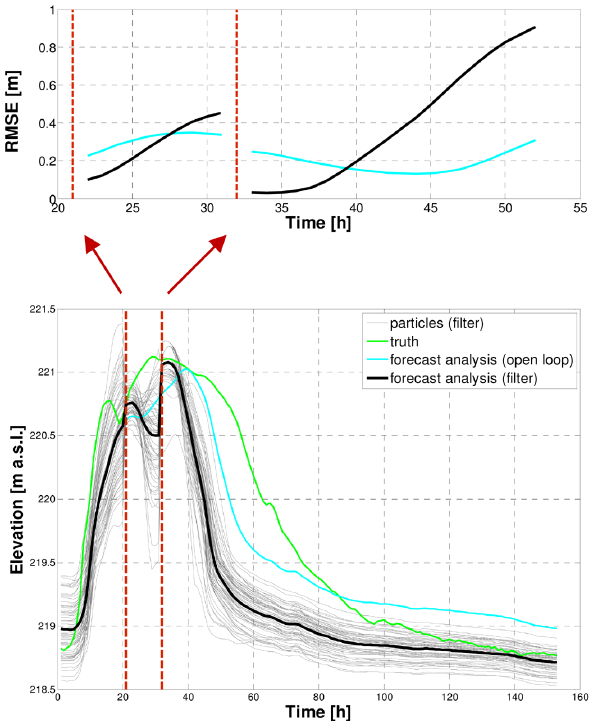
Fig. 11. Idem Fig. 9, but for the local weighting procedure and the assimilation of the ground